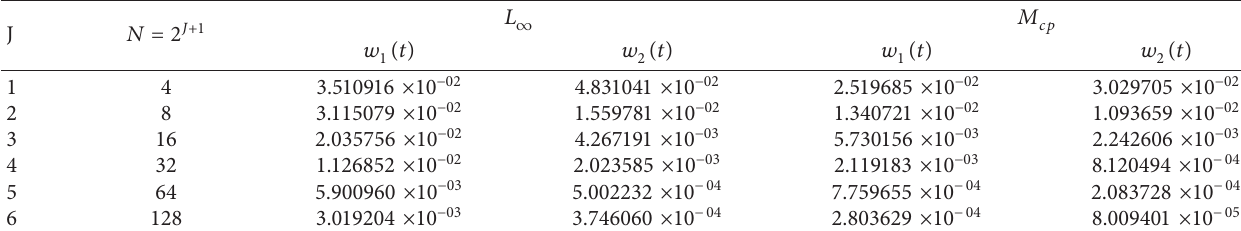
Table 5: L and M cp errors for Problem ∞